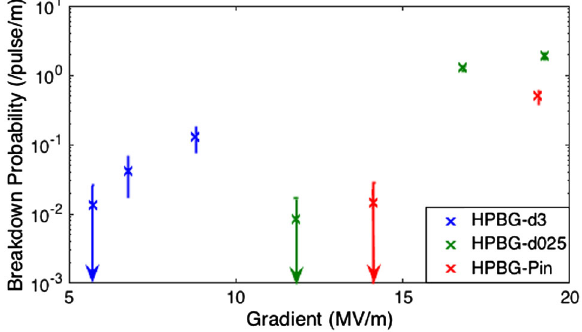
FIG. 24. Breakdown probability as a function of gradient of the three HPBG structures.